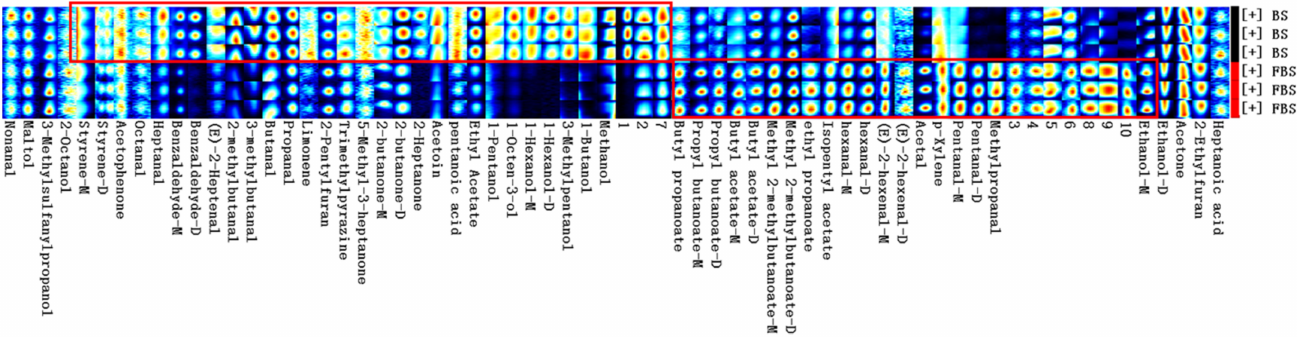
Figure 5. Gallery plot of volatile organic compounds (VOCs) fingerprints of non-fermented black soybeans (BS) and E. cristatum-fermented black soybeans